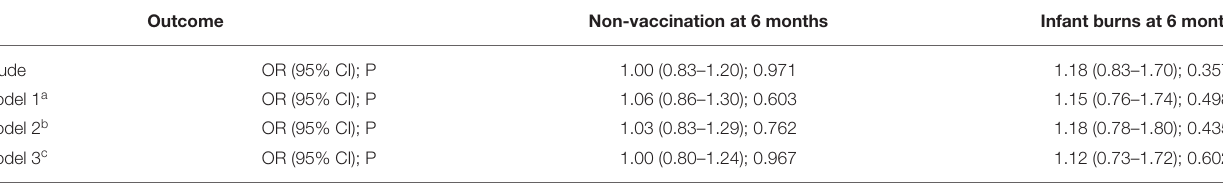
TABLE 5 | Association between shaking at 1 month postpartum and inappropriate parenting behavior at 6 months postpartum: odds ratios and 95% confidence